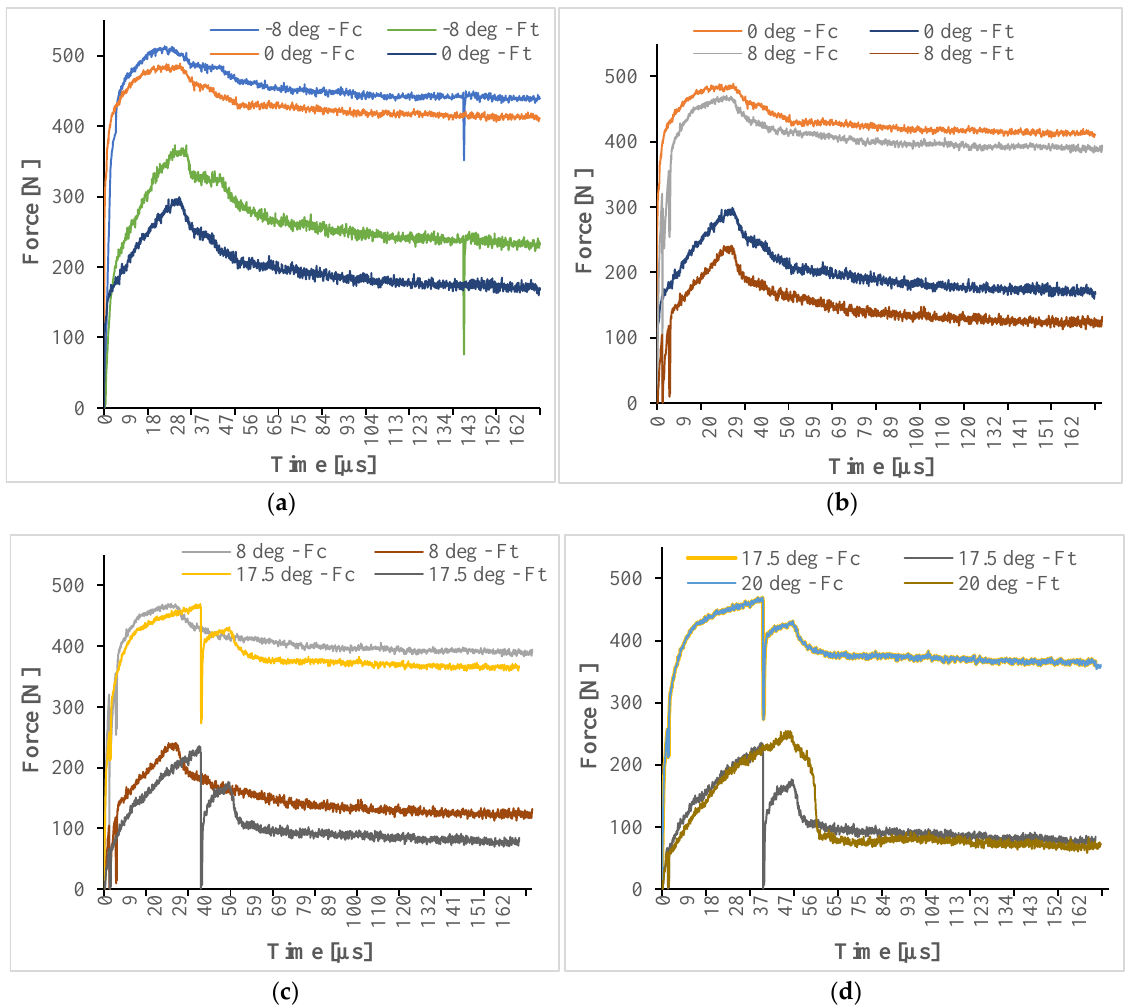
Figure 11. Force distribution during cutting process for different rake angles (α = 7° and 𝑟 𝜀 = 20 µm): ( a ) −8–0°, ( b ) 0–8°, ( c ) 8–17.5°, and ( d ) 17.5–20°.